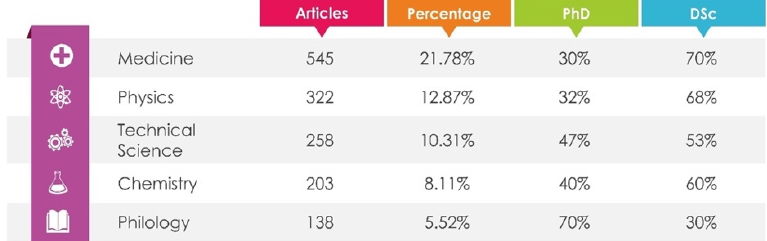
Figure 3. Top-five academic disciplines based on the number of publications 2016–2019.